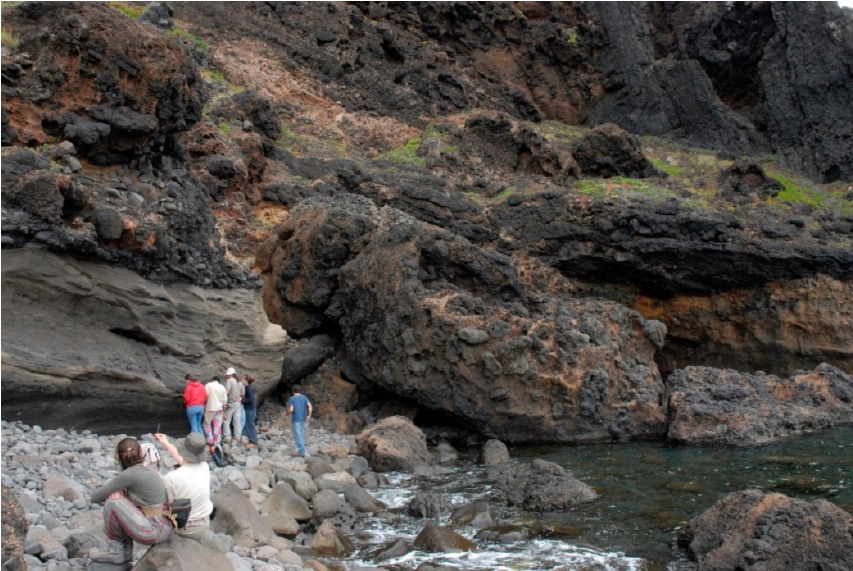
Figure 6. Modern coastal boulder deposit (CBD) eroded from basalt at Ponta do Castelo (site 3, see map in Figure 1b) and overlying Pleistocene CBD preserved at a level 4.3 m above mean sea level at the same locality (sites 4 and 5).